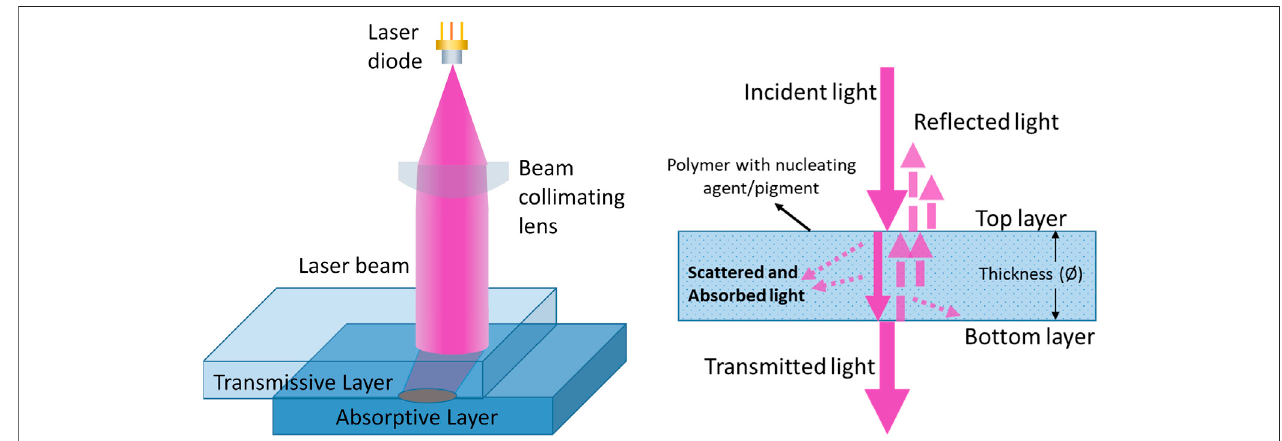
FIGURE 1 | Schematic of transmission laser welding of lap geometry of materials (left) and light transmission through transmissive layer with re fl ected, scattered and absorbed light phenomena (right).